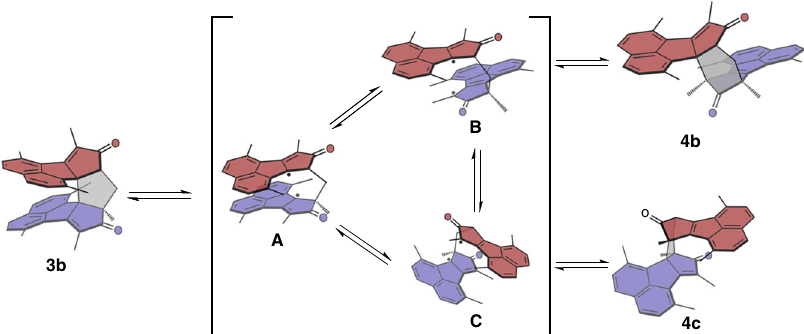
Fig. 5 Proposed biradical mechanism of the photoswitching process of 3b . The photoisomerization from 3b to 4b was shown in Supplementary Movie